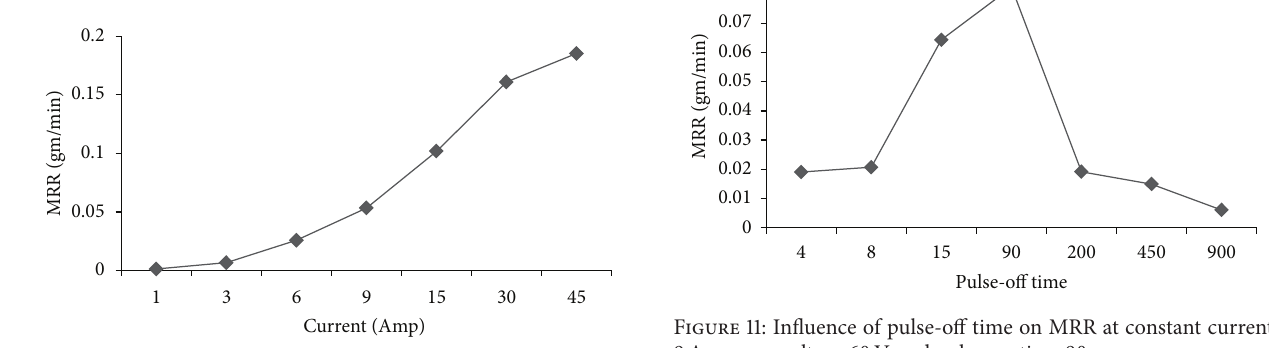
Figure 9: Influence of current on MRR at constant voltage 60 V, pulse-on time 90 𝜇 s, and pulse-off time 90 𝜇 s.